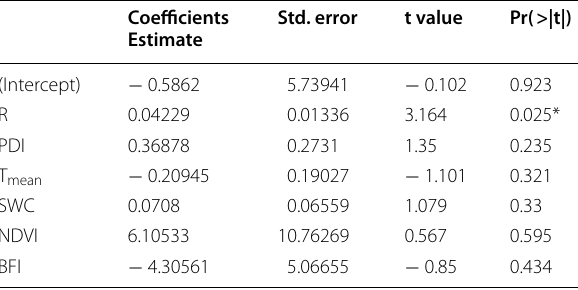
Table 3 Coefficient estimates of the full regression model for stream